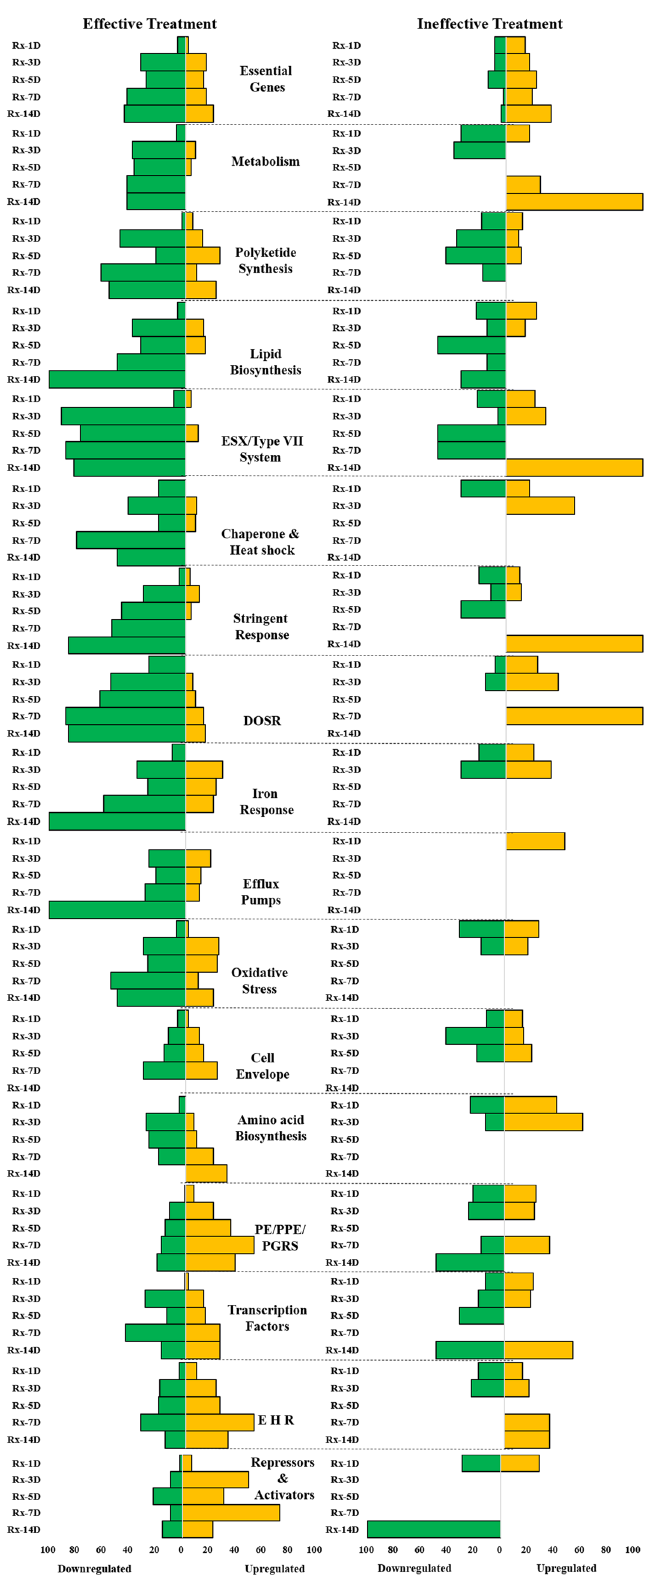
Figure 2. Change in expression of selected functional categories of genes after initiation of anti-tuberculosis treatment. The graphs illustrate the percentage of genes in each functional category significantly up- (yellow) or down- (green) regulated each day relative to pretreatment expression. The left and right side graphs represent the alterations observed in gene expression with effective and ineffective treatment, respectively. The dashed line demarcates each of the functional categories. The percentage of genes was calculated by dividing the number of genes up or down-regulated by the number of genes detected. This calculation was for genes detected at each profiled time point in the functional